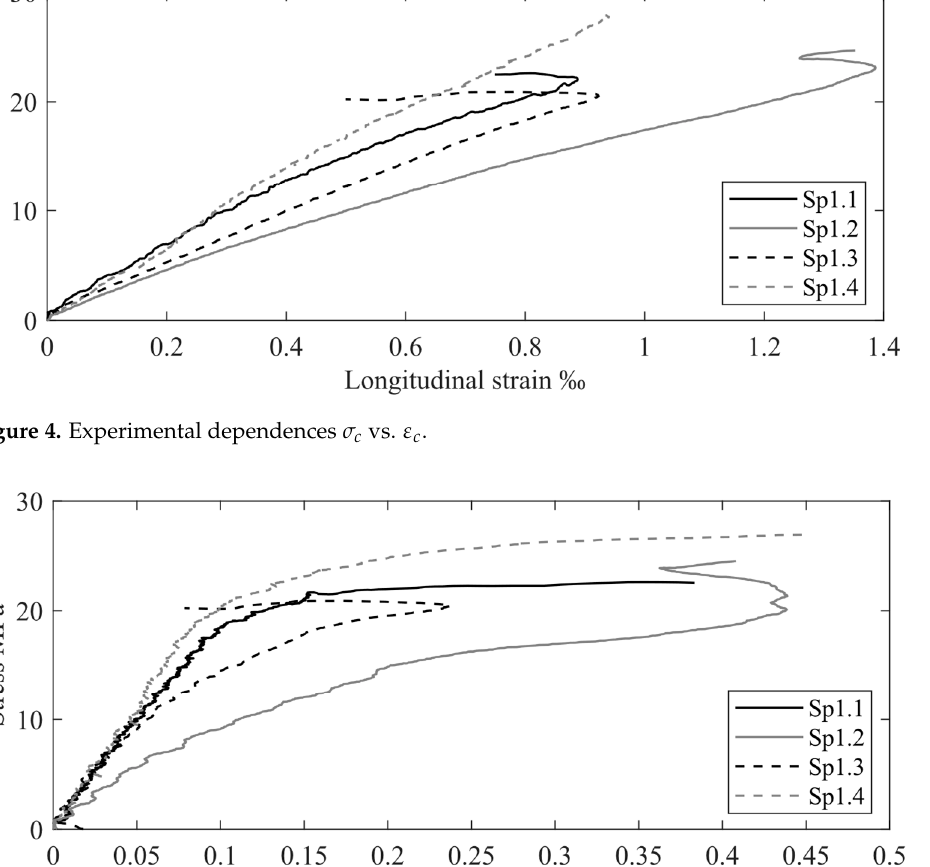
Figure 4. Experimental dependences 𝜎 (cid:3030) vs. 𝜀 (cid:3030) .